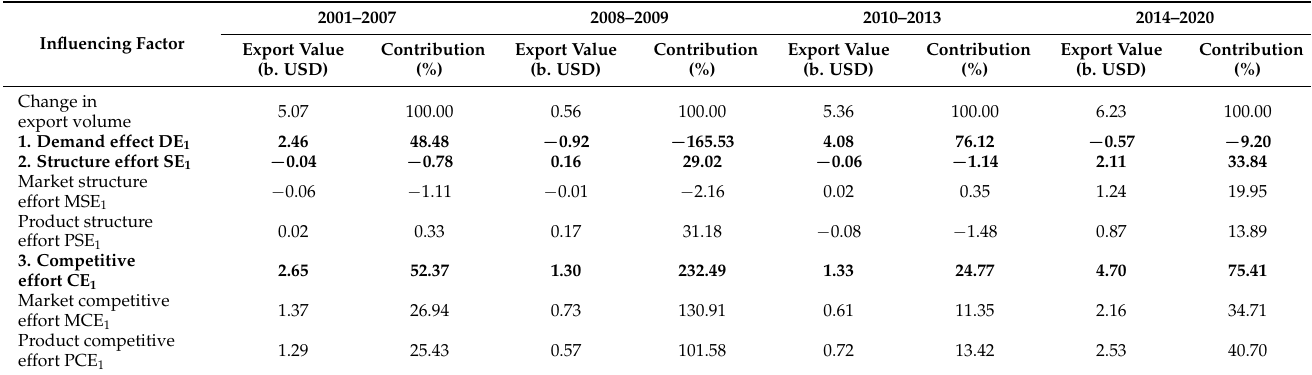
Table 1. China’s agricultural exports to B&R countries fluctuates